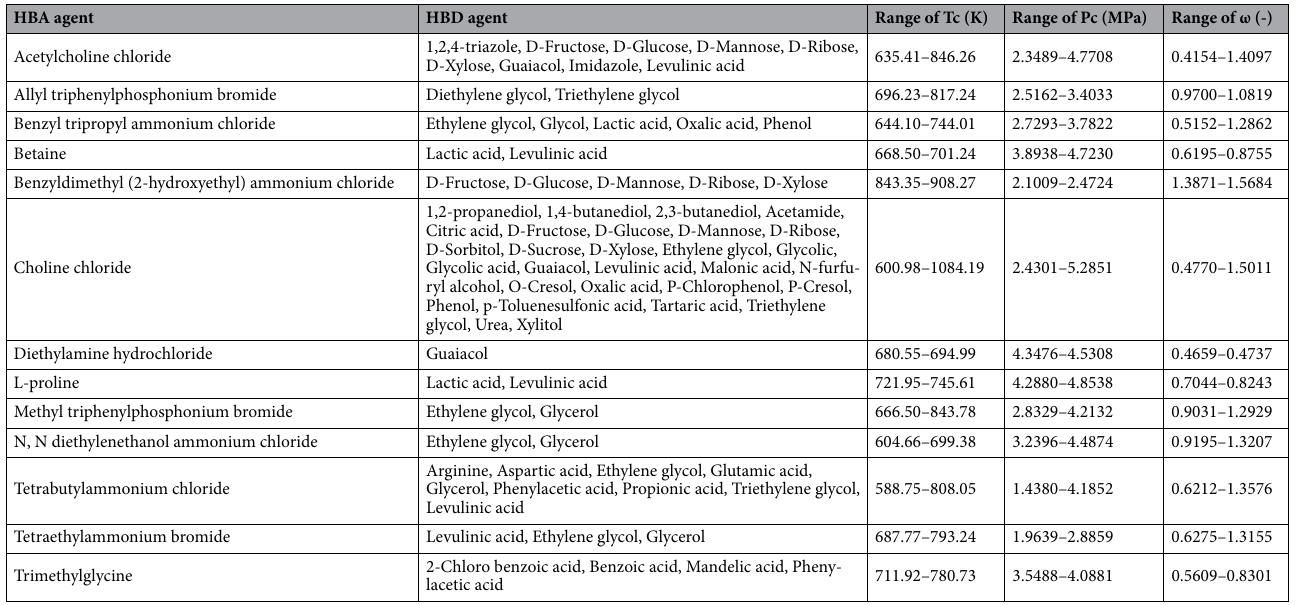
Table 2. The reported critical pressure, critical temperature, and acentric factor for the considered deep eutectic solvents 28